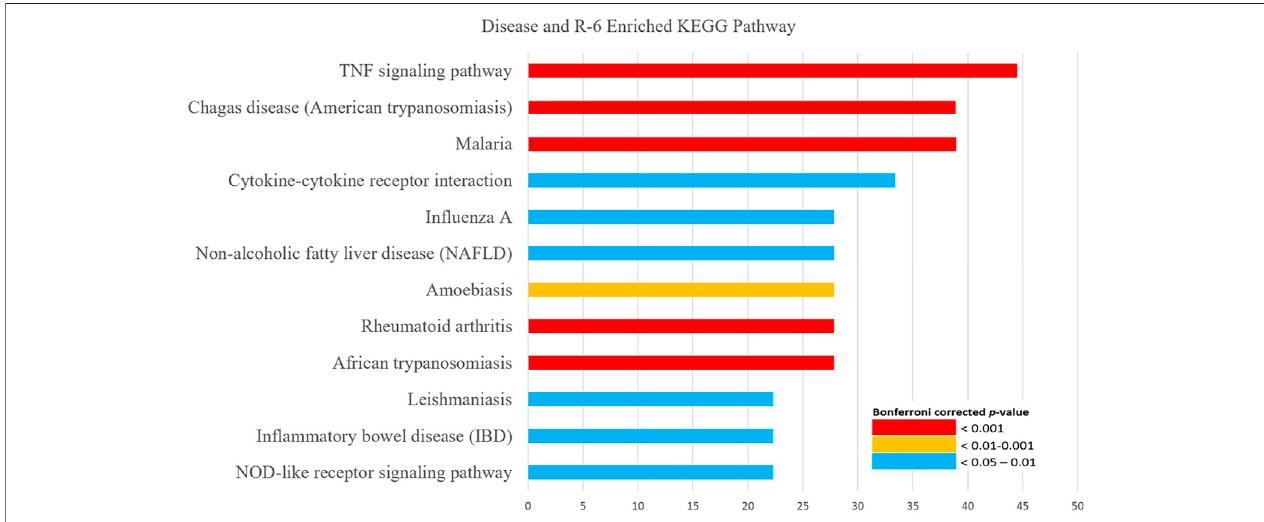
FIGURE 4 | KEGG pathway enrichment analysis of the interaction between DN and R-6. KEGG pathway analysis showed that the putative targets of R-6 on diabetic nephropathy are related to the TNF signaling pathway, NOD-like receptor signaling pathway, HIF-1 signaling pathway, PI3K-Akt signaling pathway, in fl ammatory mediator regulation of TRP channels, complement and coagulation cascades, and renin – angiotensin system.